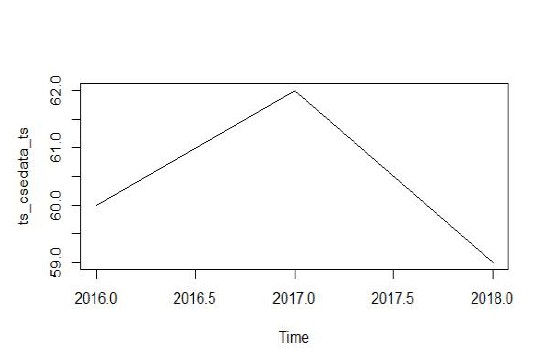
Figure 8. R plot of the input data set